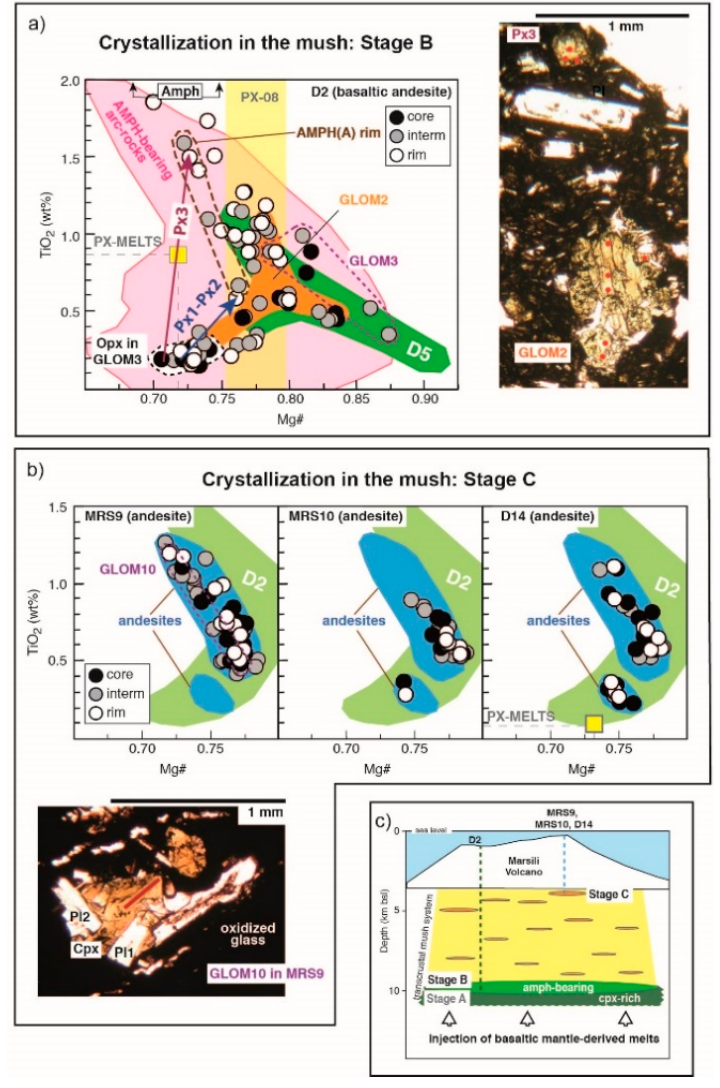
Figure 3. Clinopyroxene variability indicative of Stage B and Stage C crystallization. ( a ) TiO 2 (wt%) versus Mg# for sample D2 clinopyroxene crystals. This cargo records Stage B events, storage zone reported in ( c ). The D2 clinopyroxene trend defines a continuum with the field of D5 clinopyroxenes (Stage A, green field) before splitting into two branches at the lowest Mg# values (see GLOM2, or ‐ ange field), pointing, respectively, to the compositional fields of orthopyroxene (low Ti, black dotted